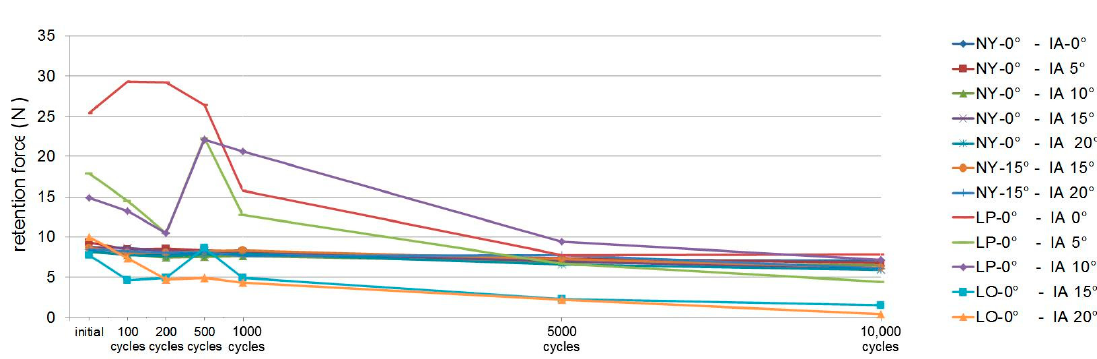
Figure 6. Retention force curves corresponding to artificial ageing per test series; for labeling, see Table